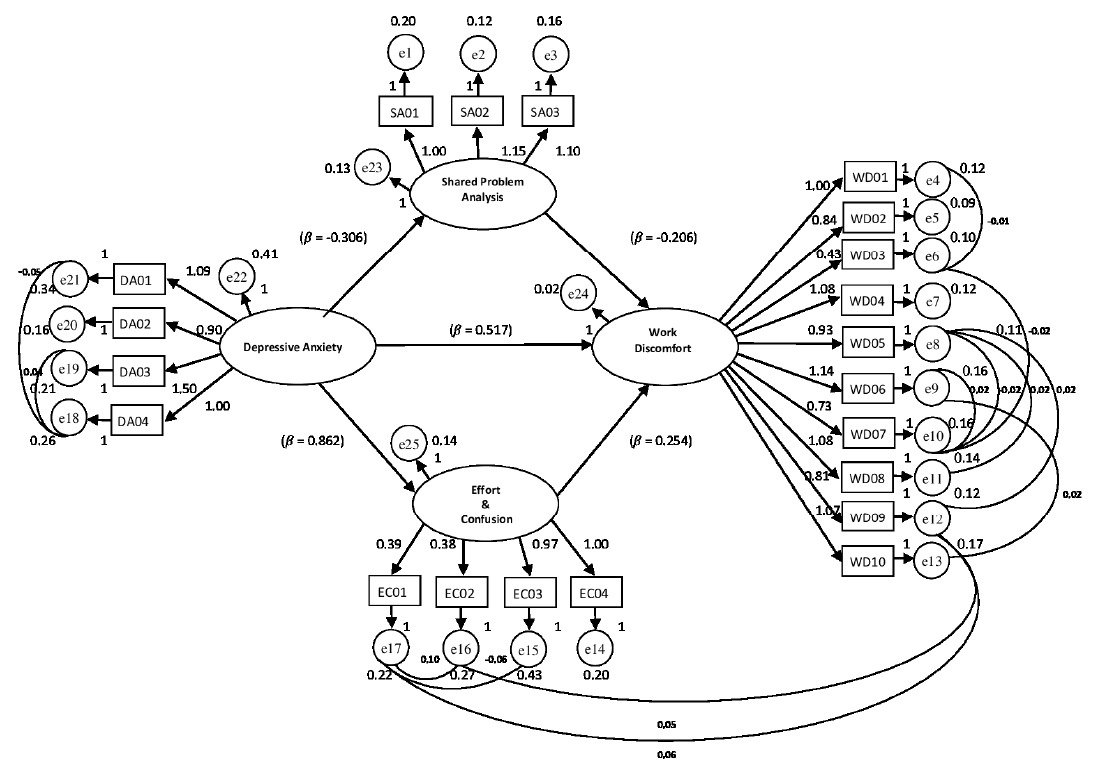
Figure 2. Path Model. Table 6. Maximum likelihood estimates and standardized weight